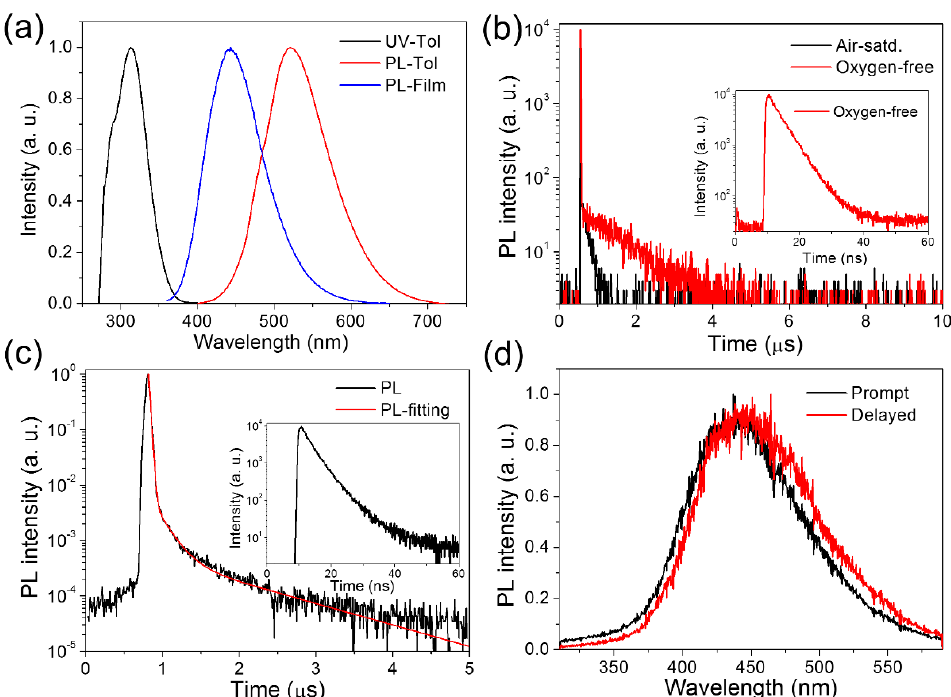
Figure 3. ( a ) The UV-vis and PL spectra of HAP-3DPA in toluene (Tol) and doped film (6 wt% HAP-3DPA:DPEPO). ( b ) Transient PL decay of HAP-3DPA in air-saturated (Air-satd.) and oxygen-free toluene. Inset: Transient PL decay of HAP- 3DPA in oxygen-free toluene with a time range of 60 ns. ( c ) Transient PL decay of the 6 wt% HAP-3DPA:DPEPO-doped film. Inset: Transient PL decay in a time range of 60 ns. ( d ) Prompt and delayed PL spectra of the 6 wt%